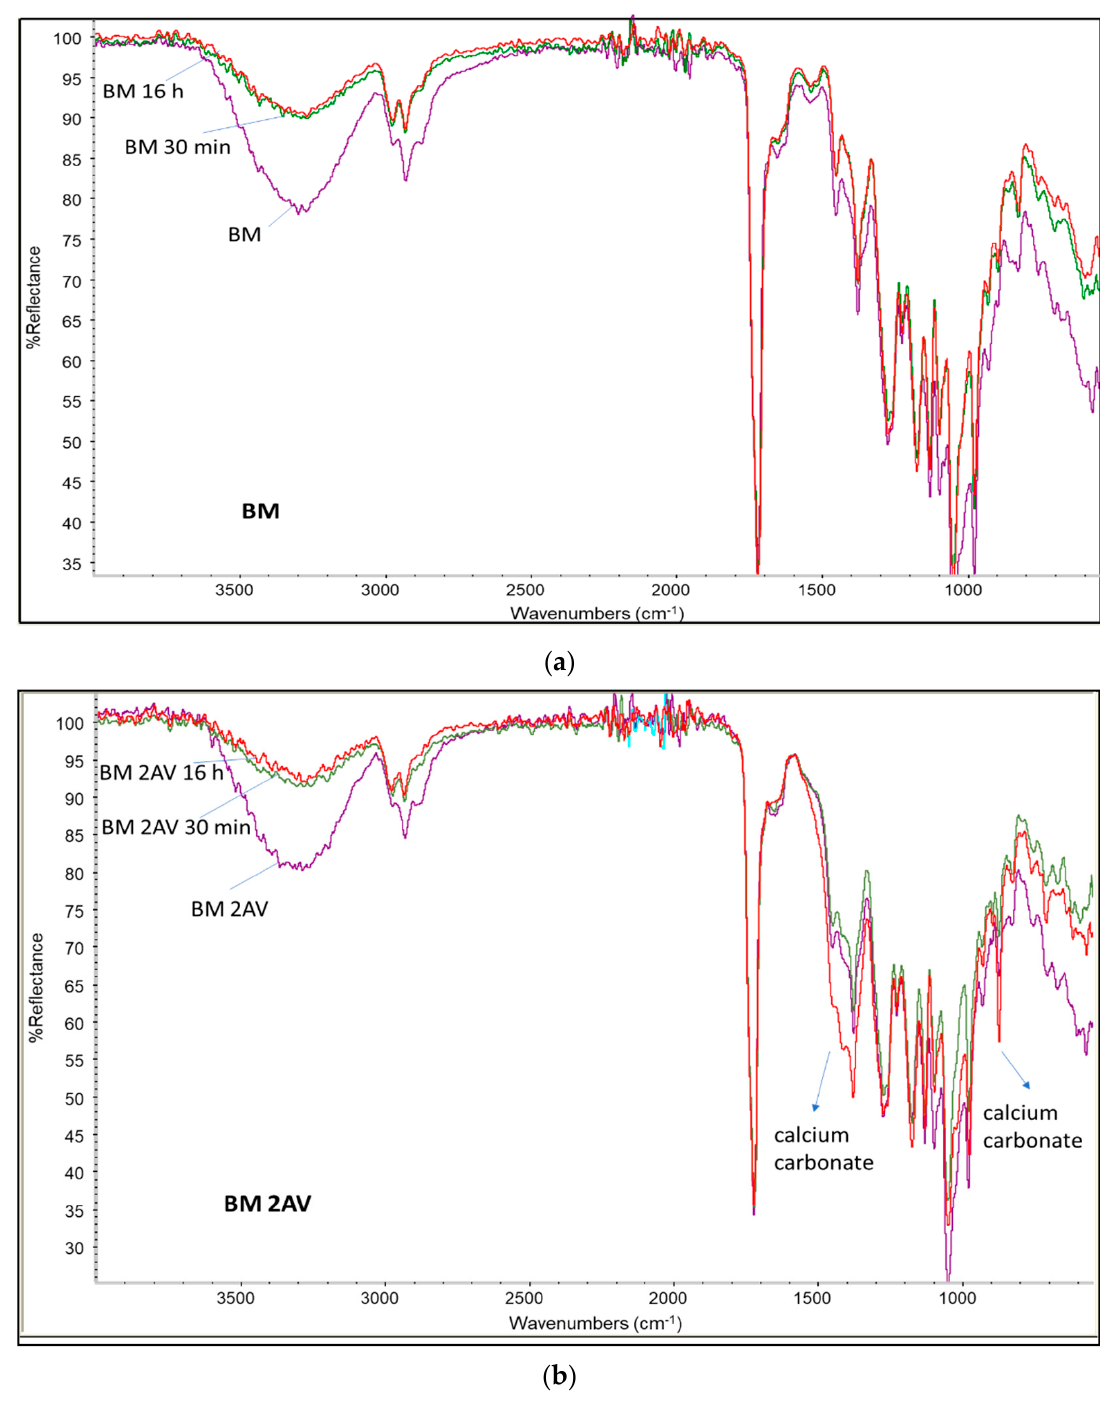
Figure 3. Infrared spectra of films before and after immersion in water at different times (30 min and 16 h): ( a ) BM (purple) and BM after water extraction of 30 min (green) and 16 h (red); ( b ) spectrum of BM 2AV (purple) and the same after water extraction of 30 min (green) and 16 h (red); ( a ) spectrum of BM SMART before (blue) and after water extraction of 30 min (red) and 16 h (green).